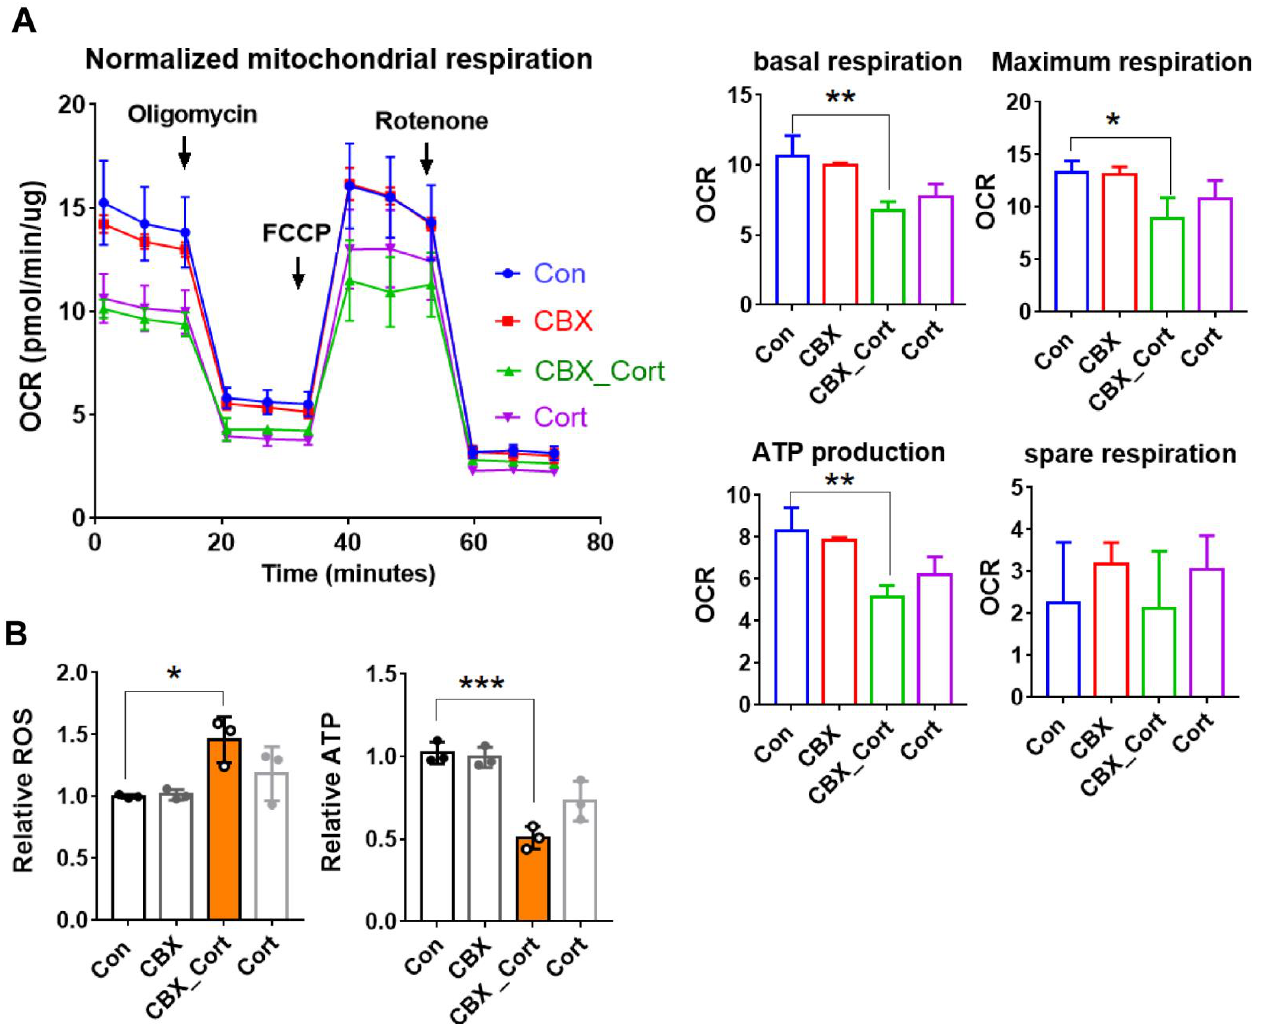
Figure 5. The effects of 11β -HSD2 dysfunction on mitochondrial function and MtDNA content in EVTs. HTR8 cells were treated with cortisol (10 −6 M) in the presence and absence of CBX (10 −6 M) for 24 – 48 h, and then the cells were used for OCR analysis, or harvested for mitochondria isolation and Q-PCR analysis. ( A ) Seahorse mitochondrial stress assay. Left panel : representative traces of OCR. Right panel : cumulative data of basal respiration, maximal respiration, ATP production and spare respiratory capacity. ( B ) mitochondrial function assay of ROS and ATP production. n = 3 independent cultures. * p < 0.05, ** p < 0.01, *** p < 0.001 Con: control; Cort: cortisol, CBX_Cort: CBX combined with cortisol.